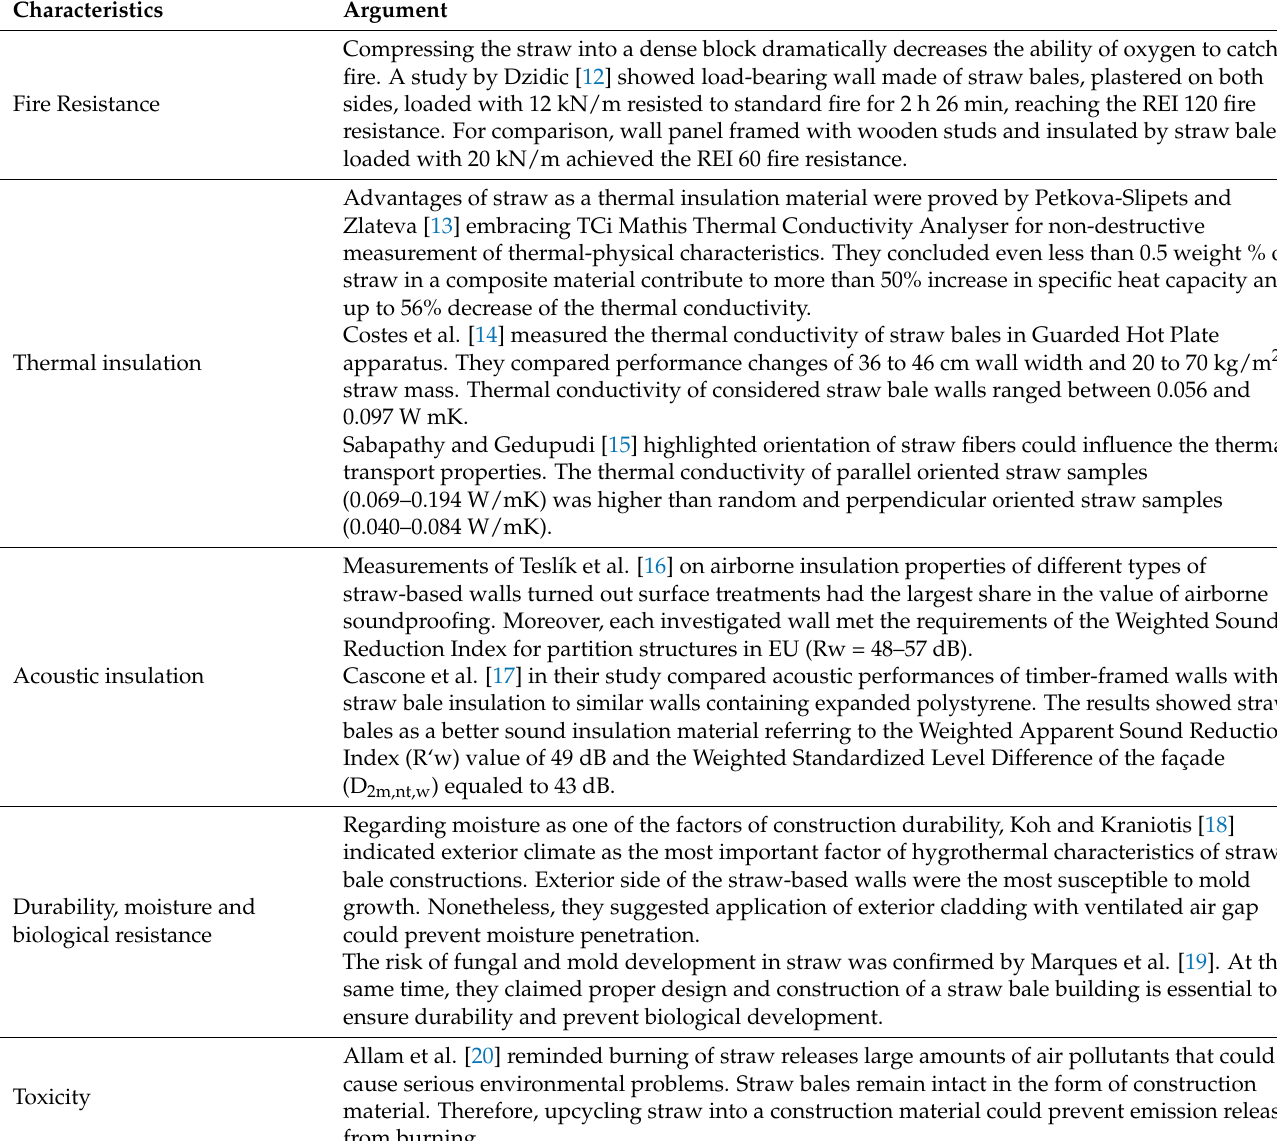
Table 1. Selected characteristics of